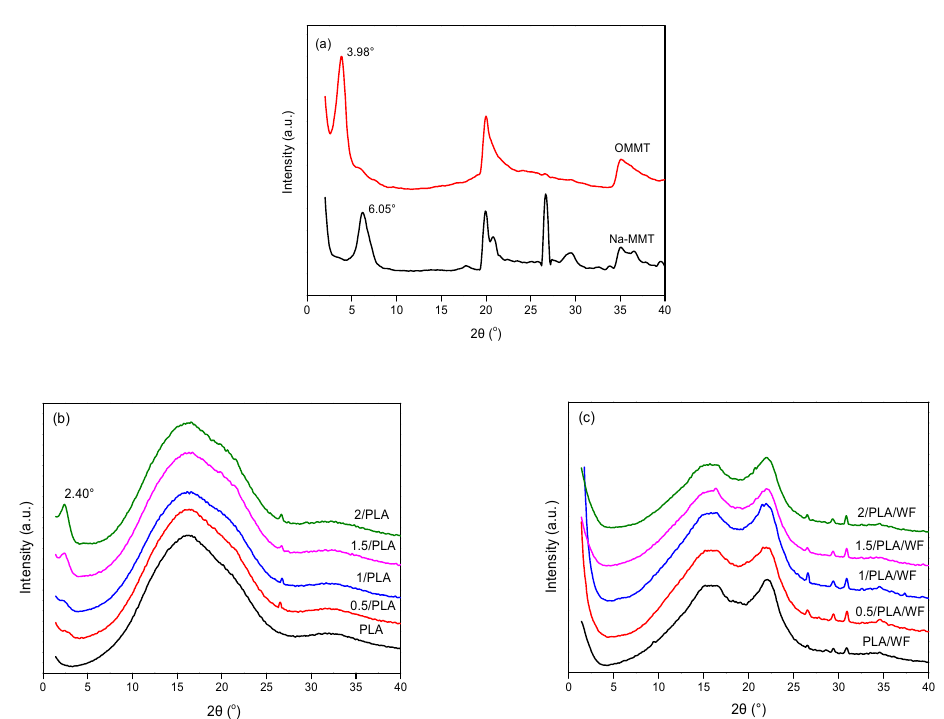
Figure 1. XRD patterns of Na-montmorillonite (MMT) and organo-montmorillonite (OMMT) powders ( a ), virgin and OMMT-modified poly(lactic acid) (PLA) ( b ), and the composites ( c ).